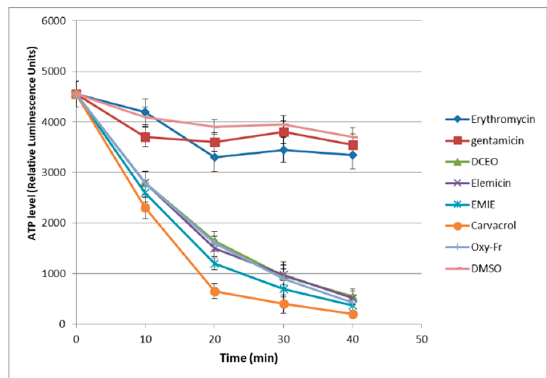
Figure 4. Intracellular ATP level in Campylobacter cells after treatment with the entire DCEO, the oxygenated fraction and purified active molecules. Data are the means ± SEM from three independent experiments.